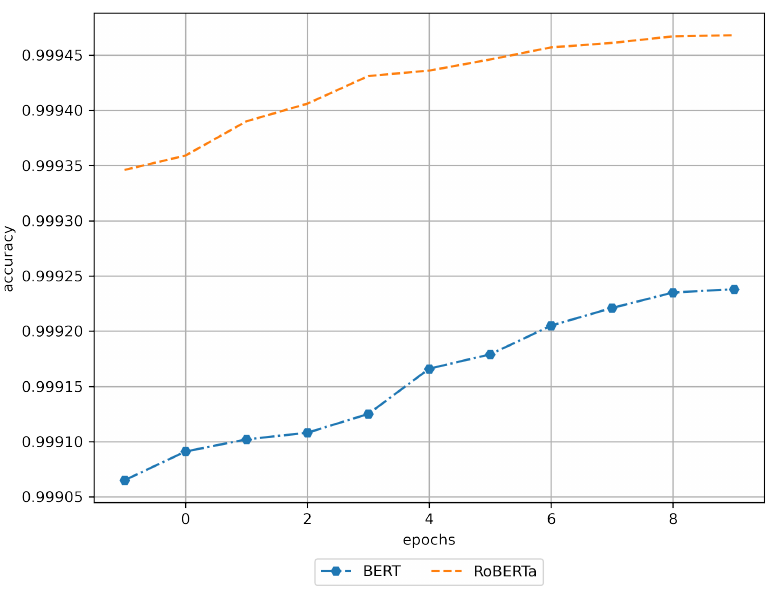
Figure 2. Evolution of the accuracy of neural networks devoted to filling in the blanks during the training